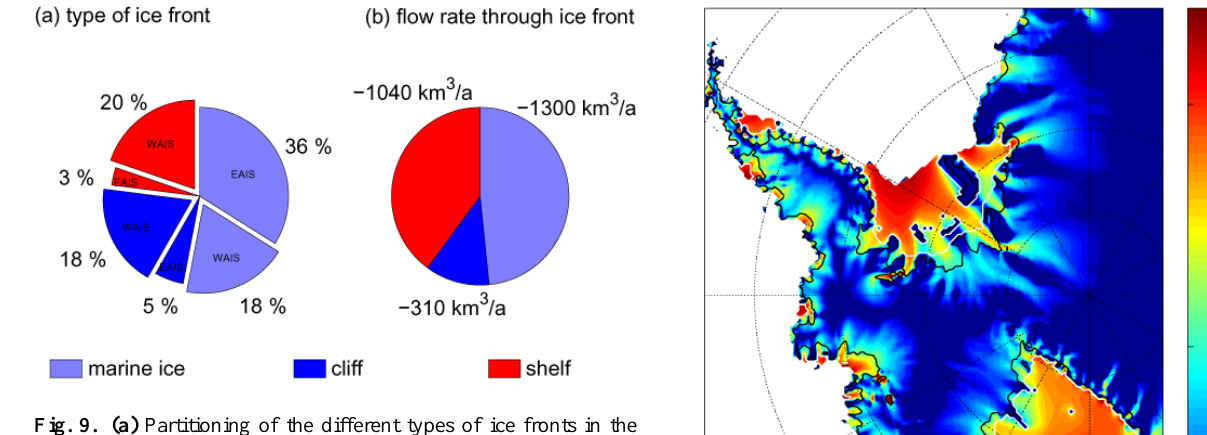
Fig. 9. (a) Partitioning of the different types of ice fronts in the equilibrium simulation, and (b) their contribution to the mass bud- get. Note that an ice flow of − 1190km 3 a − 1 can be attributed to East Antarctica.